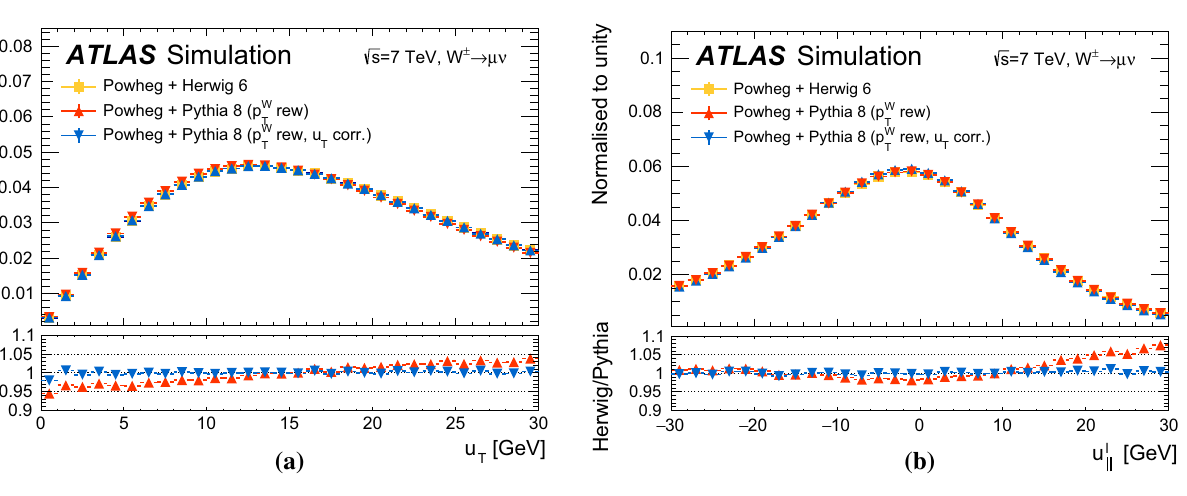
Fig. 13 Distributions of a u T and b u (cid:7) (cid:5) in W events simulated using Powheg+Pythia 8 and Powheg+Herwig 6 . The recoil response in Powheg+Pythia 8 is corrected to the Powheg+Herwig 6 response using simulated Z events following the method described in the